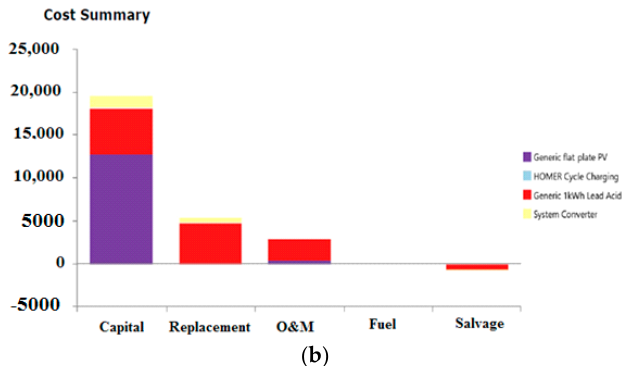
Figure 7. ( a ) Hybrid energy system with battery; ( b ) Cost summary.